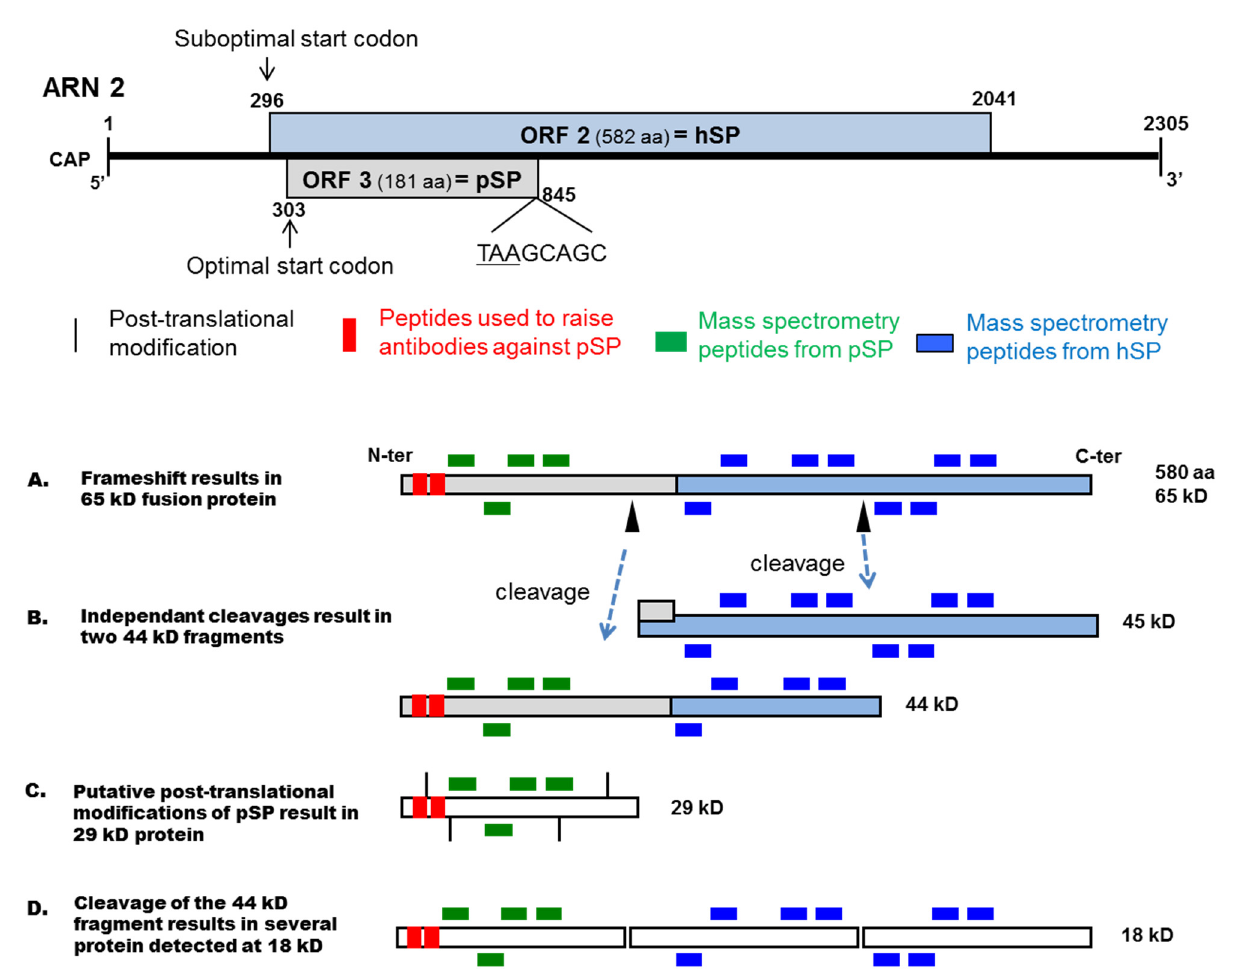
Figure 5. Putative translation mechanism and proteins maturation of ORFs 2 and 3 on CBPV RNA 2. Top: Diagram of predicted genome organisation of ORFs 2 and 3 on CBPV RNA 2. The ORFs are indicated with their positions and putative amino acid sequence length. aa: amino acid, pSP: predicted structural protein, hSP: hypothetical structural protein; ( A ) Putative fusion protein capsid of about 65 kD resulting from translation initiation from the first ATG of ORF 3 and recovery of ORF 2 around the STOP codon of ORF 3; ( B ) The p65 may be cleaved by means of two non-simultaneous cleavage sites (arrowheads) into two proteins of about 45 kD, pSP until mid of p65 and mid- C -terminal region of p65 corresponding to immunodetected protein about 44 kD; ( C ) The immunodetected protein of about 28 kD may be pSP alone with post-translational modifications; ( D ) The products of maturation of about 44 kD may be cleaved into several proteins corresponding to immunodetected proteins at about 18